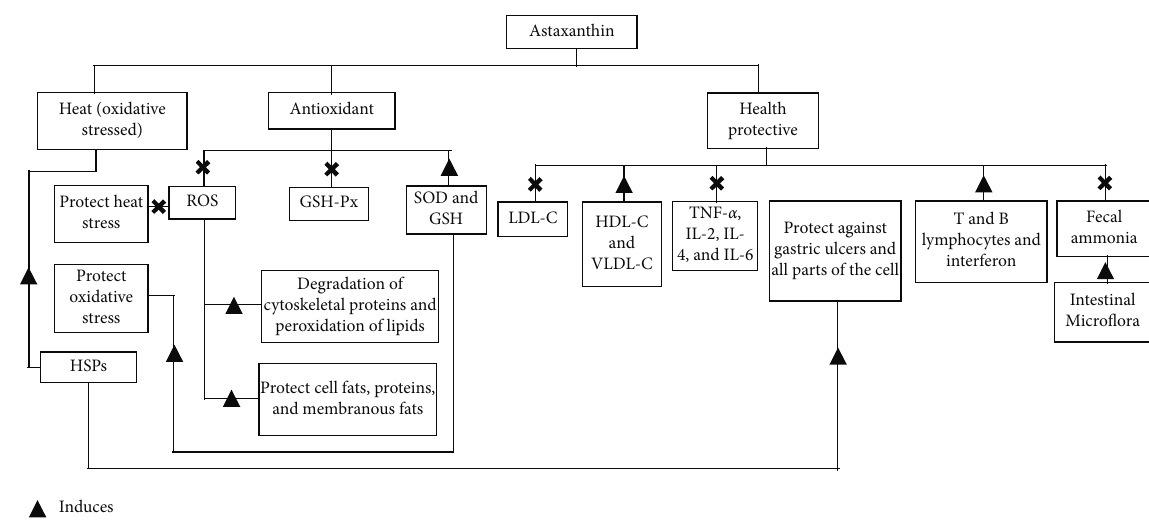
Figure 2: The role of astaxanthin in broiler